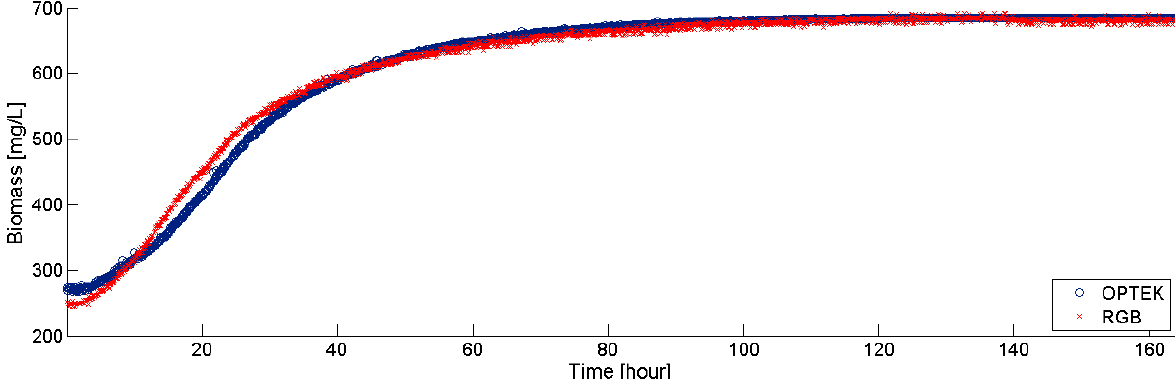
Figure 8. Data collection using an RGB sensor and Optek sensor in a microalgal